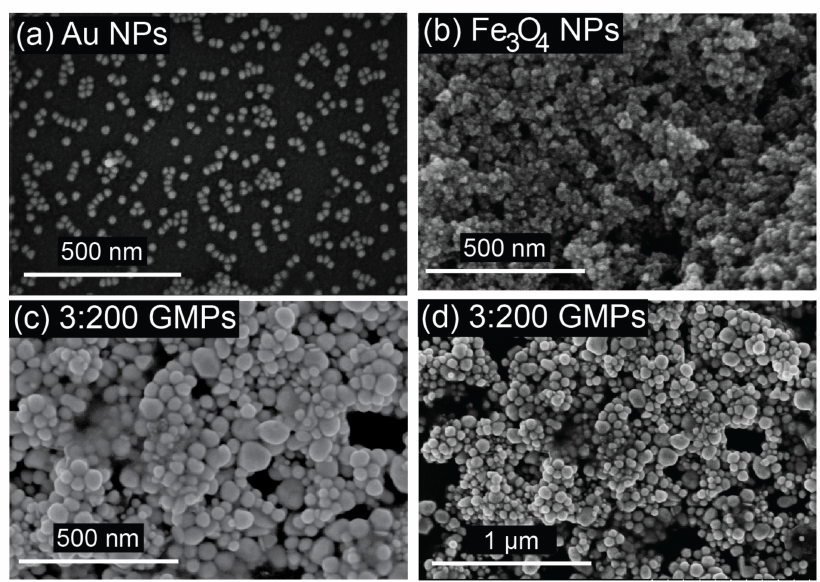
Figure 4. FESEM images of ( a ) Fe 3 O 4 NPs, ( b ) Au NPs, and 3:200 GMPs, with scale bars indicating ( c ) 500 nm and ( d ) 1 µ m.